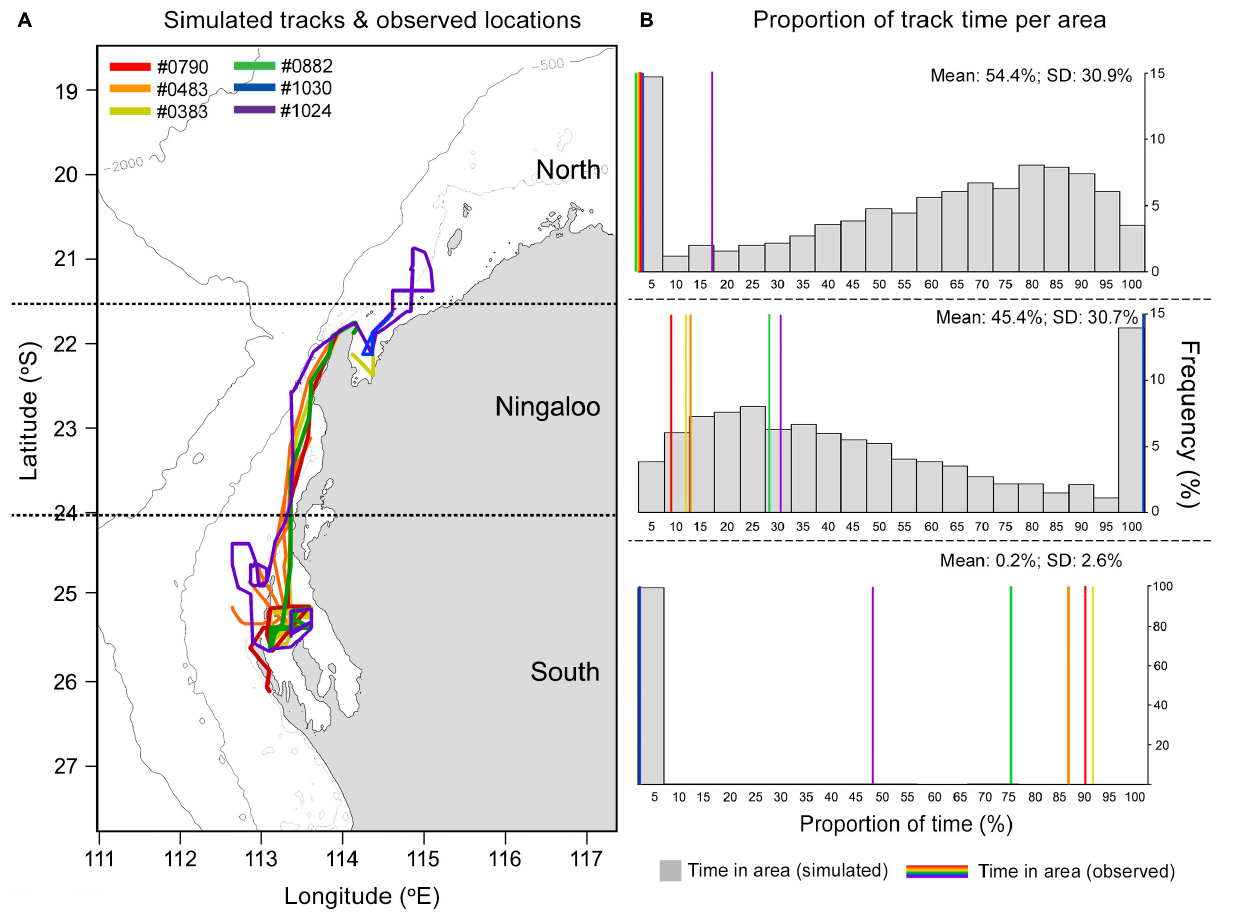
FIGURE 7 | Tracks for 6 miniPAT tags deployed in October (A) and the proportion of time (B) simulated tracks (grey bars) and observed tracks (coloured lines) occupy latitudes to the north of Ningaloo Marine Park (top right), encompassing Ningaloo Marine Park (mid right) or south of Ningaloo marine park (bottom right). Map contours indicate 500 m (innermost) and 2000 m (outermost)